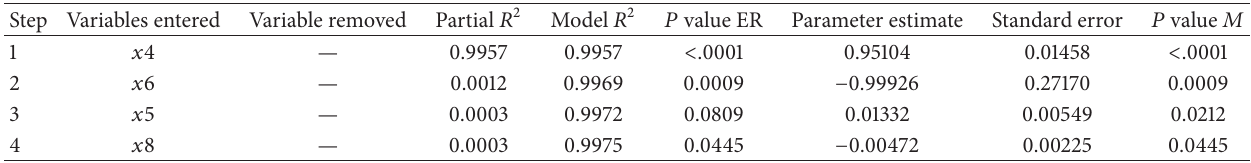
Table 6: Relative contribution (partial and model 𝑅 2 ), 𝐹 value, and probability in predicting wheat grain yield by the stepwise procedure analysis under inoculation condition and different water levels.